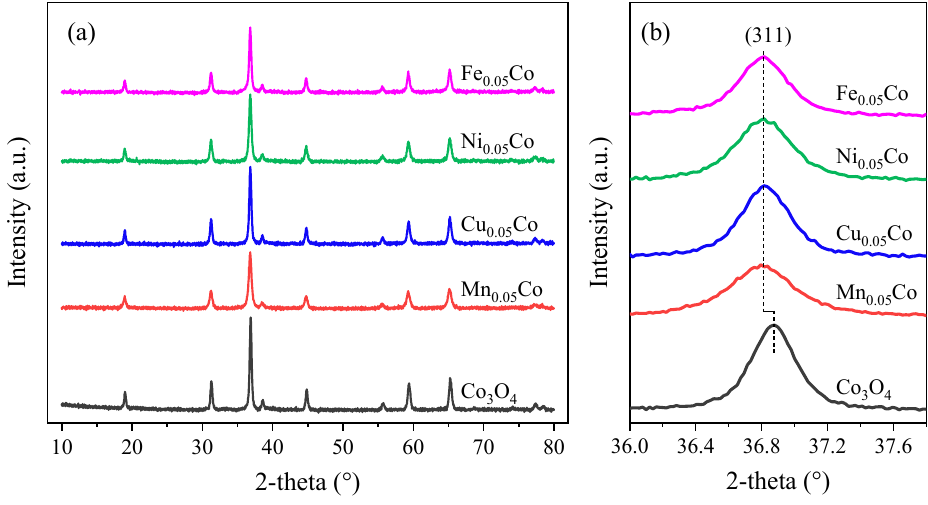
Figure 1. ( a , b ) XRD patterns of the Co 3 O 4 and M 0.05 Co Figure 1. XRD patterns of the Co 3 O 4 and M 0.05 Co catalysts.